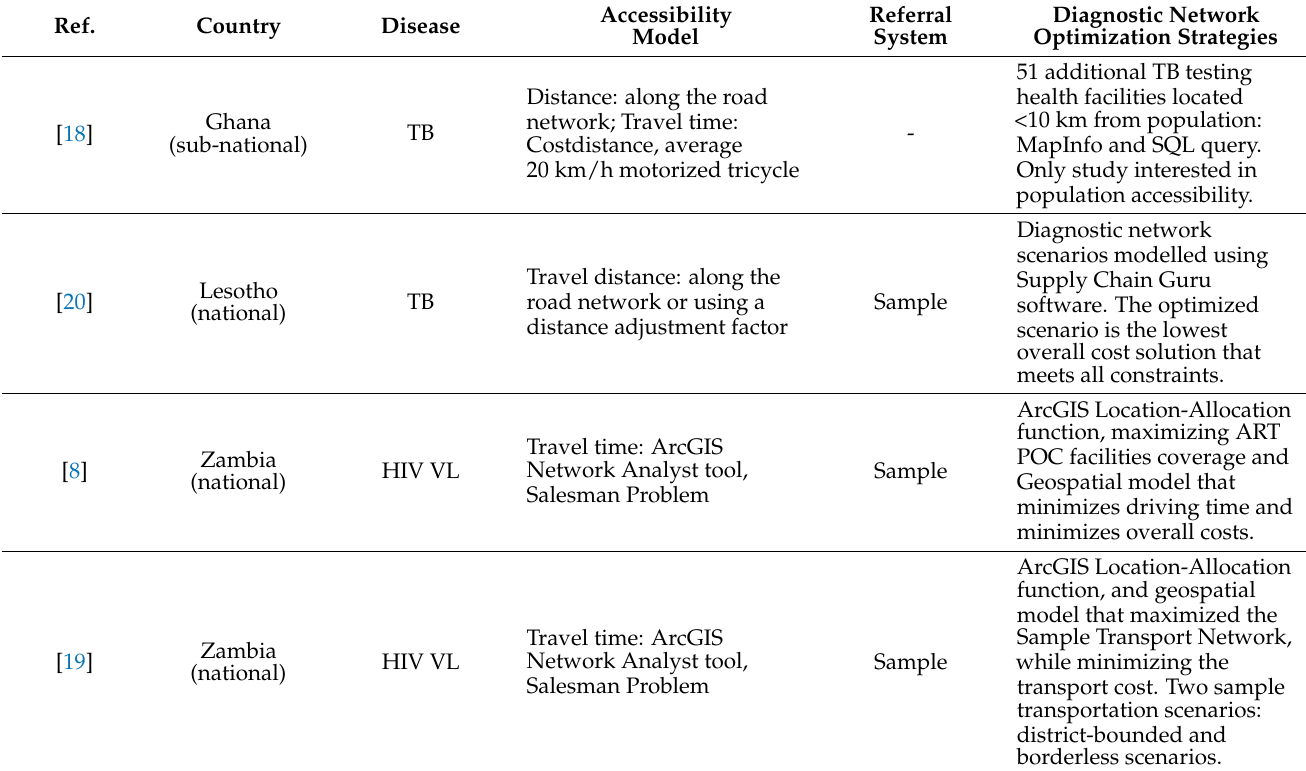
Table 1. Summary of information from the selected